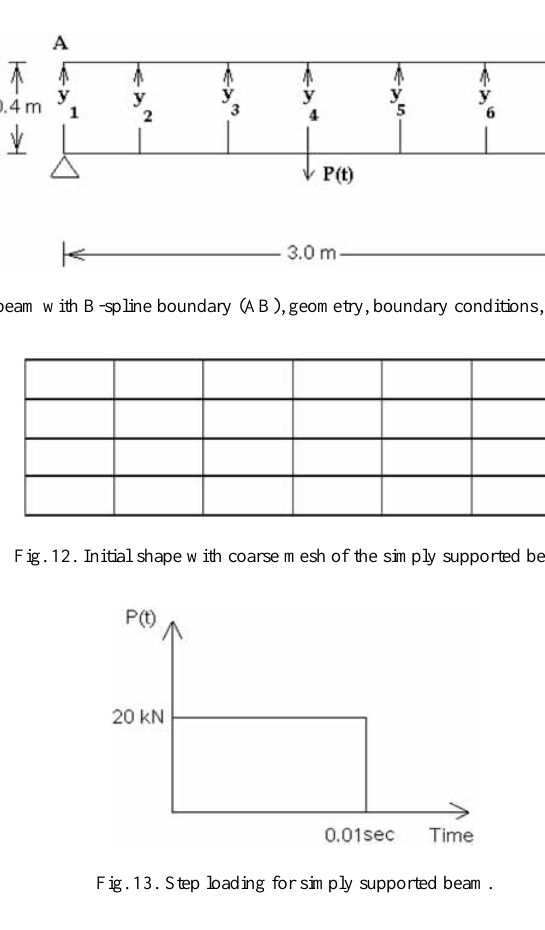
Fig. 10. Genetic evolution of area factor with varying genetic parameters (cantilever beam).